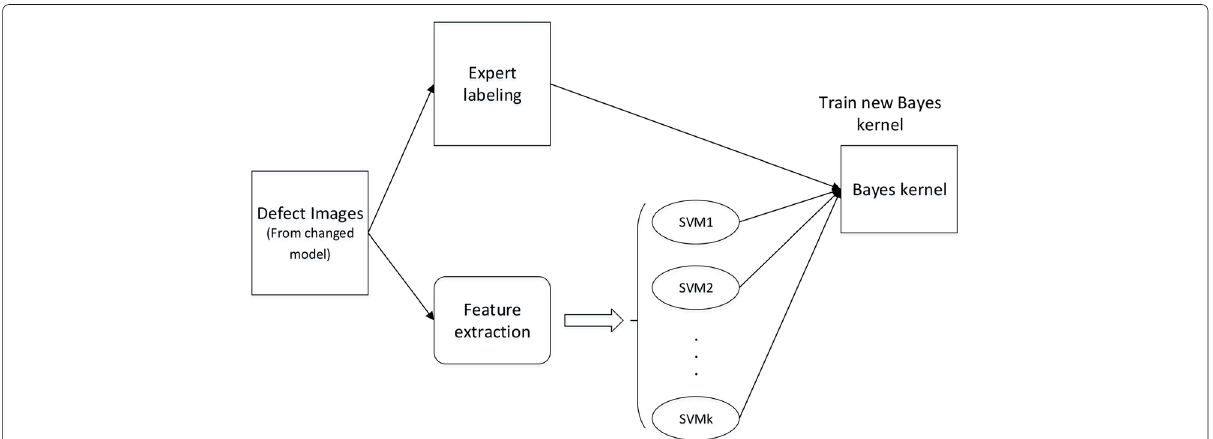
Fig. 2 Process to adjust the classifier with samples from a changed production line